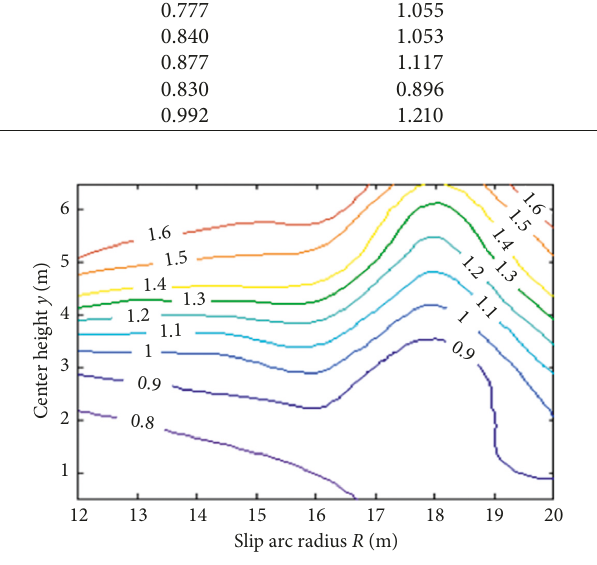
Figure 7: The contour of the safety factors of the slip surfaces.